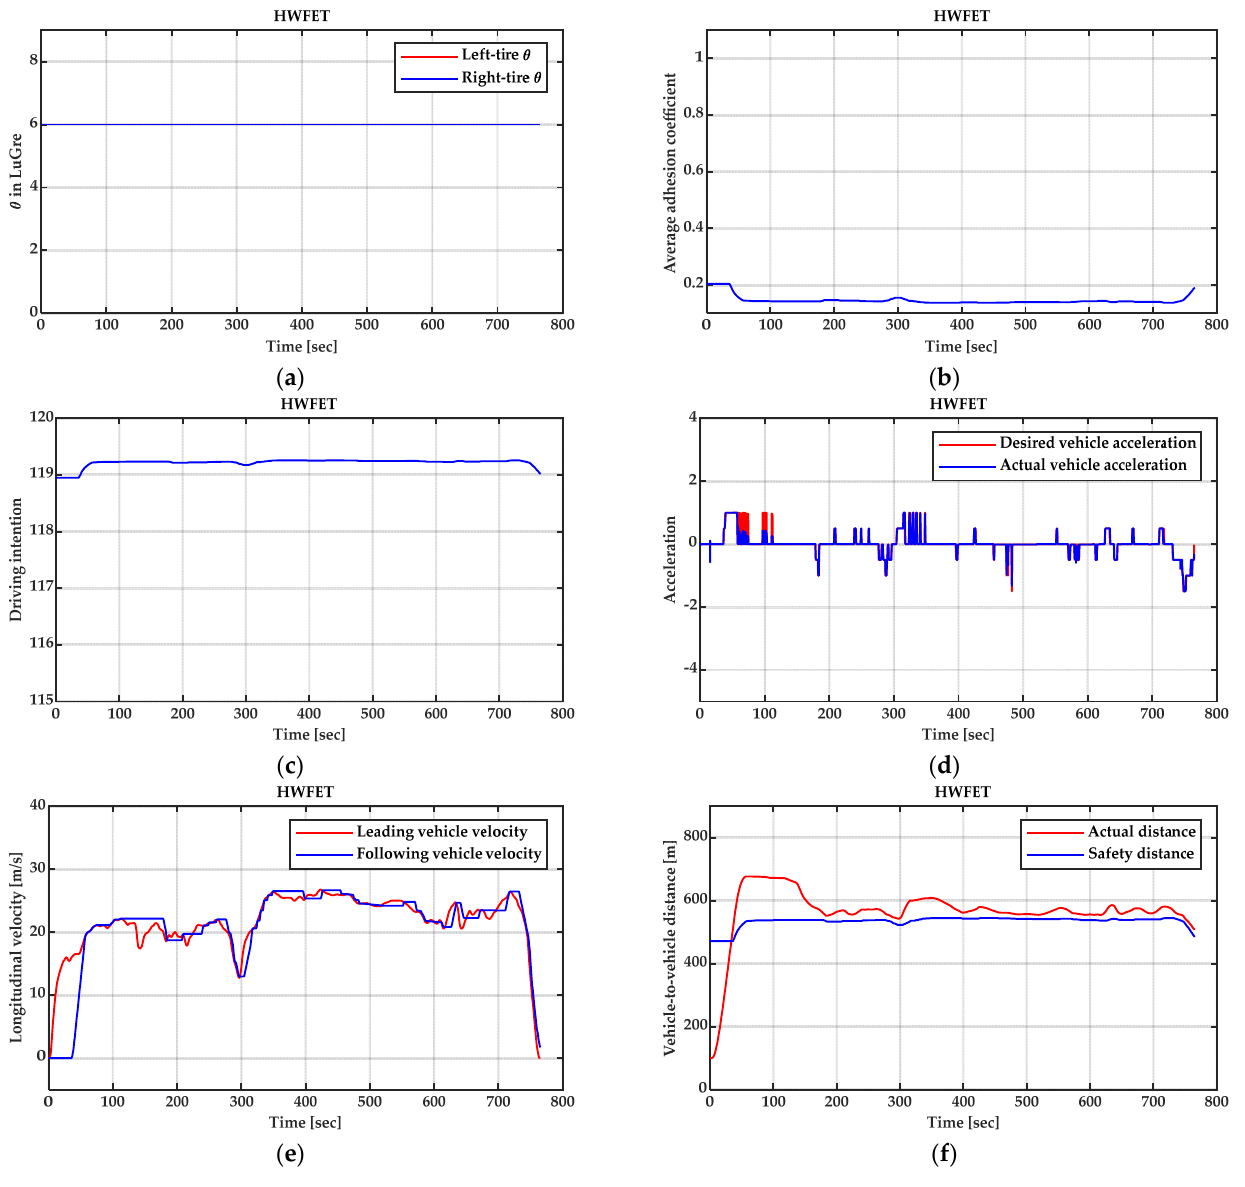
Figure 8. Snow and ice road experiments in HWFET with deep neural network. ( a ) Road character- istic parameter of left and right tires. ( b ) Average adhesion coefficient. ( c ) Driving intention. ( d ) Acceleration of following vehicle. ( e ) Longitudinal velocities of leading and following vehicles. ( f ) Vehicle-to-vehicle distance and actual distance.